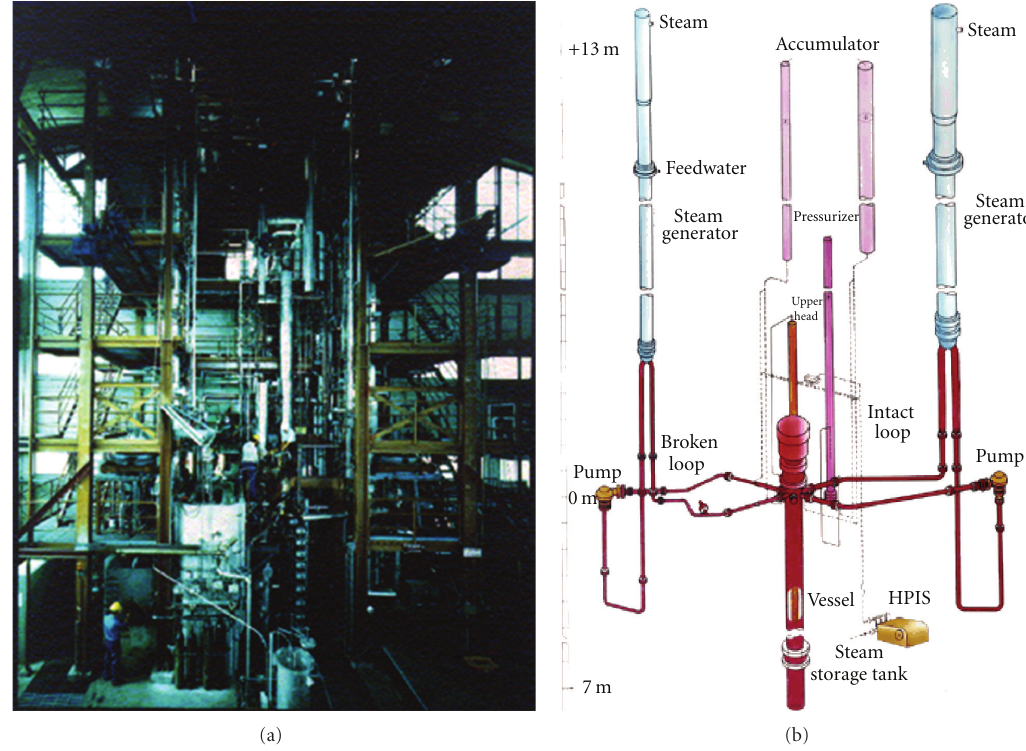
Figure 1: LOBI-MOD2 test facility and schematic representation of the cooling system (STRESA JRC database). the uppermost elevation; (3) possible hot leg to core barrel clearance fit. The sum of (2) and (3) by-pass flows mentioned has been estimated at 2.4 to 3.7% of nominal core